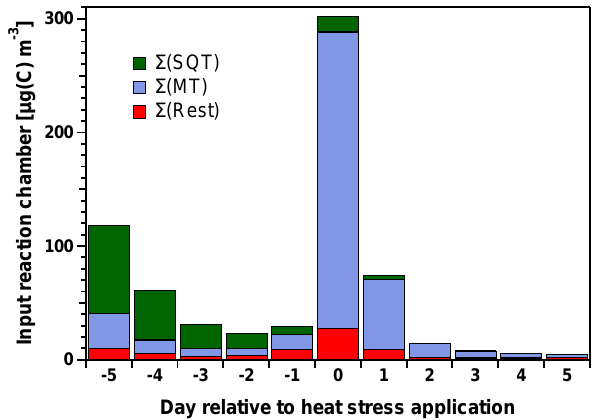
Fig. 3. Maximum BSOA mass (orange circles, left scale) and OH concentrations (blue squares, right scale) upon addition of up to 55µgm − 3 of MeSa to the reaction chamber in Experiment #1c. The α -pinene concentration was held constant at 27 ± 3µgm − 3 . The line shows the result of linear regression analysis giving the yield of 20 ± 3% ( R 2 = 0 . 83).